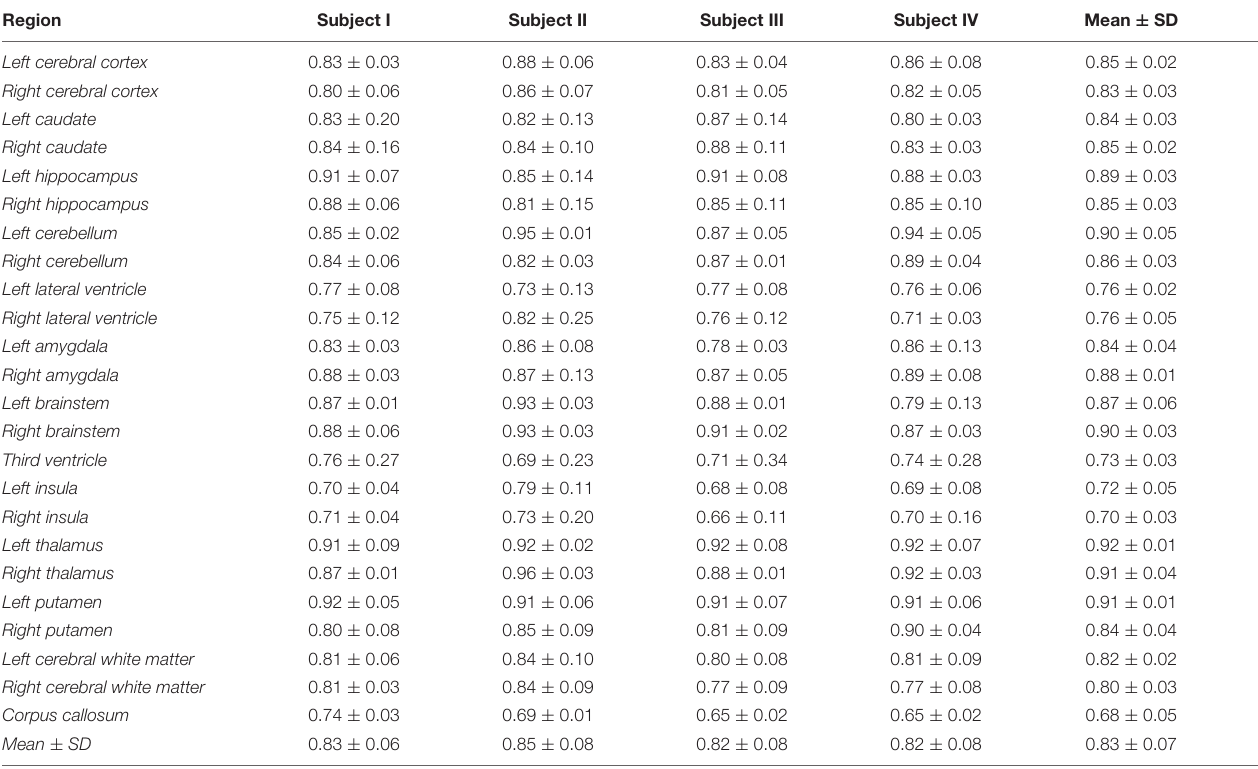
TABLE 2 | Atlas evaluation on T1-weighted magnetic resonance imaging (MRI) of four brain subjects by dice similarity coefficient between atlas and expert’s manual segmentation.